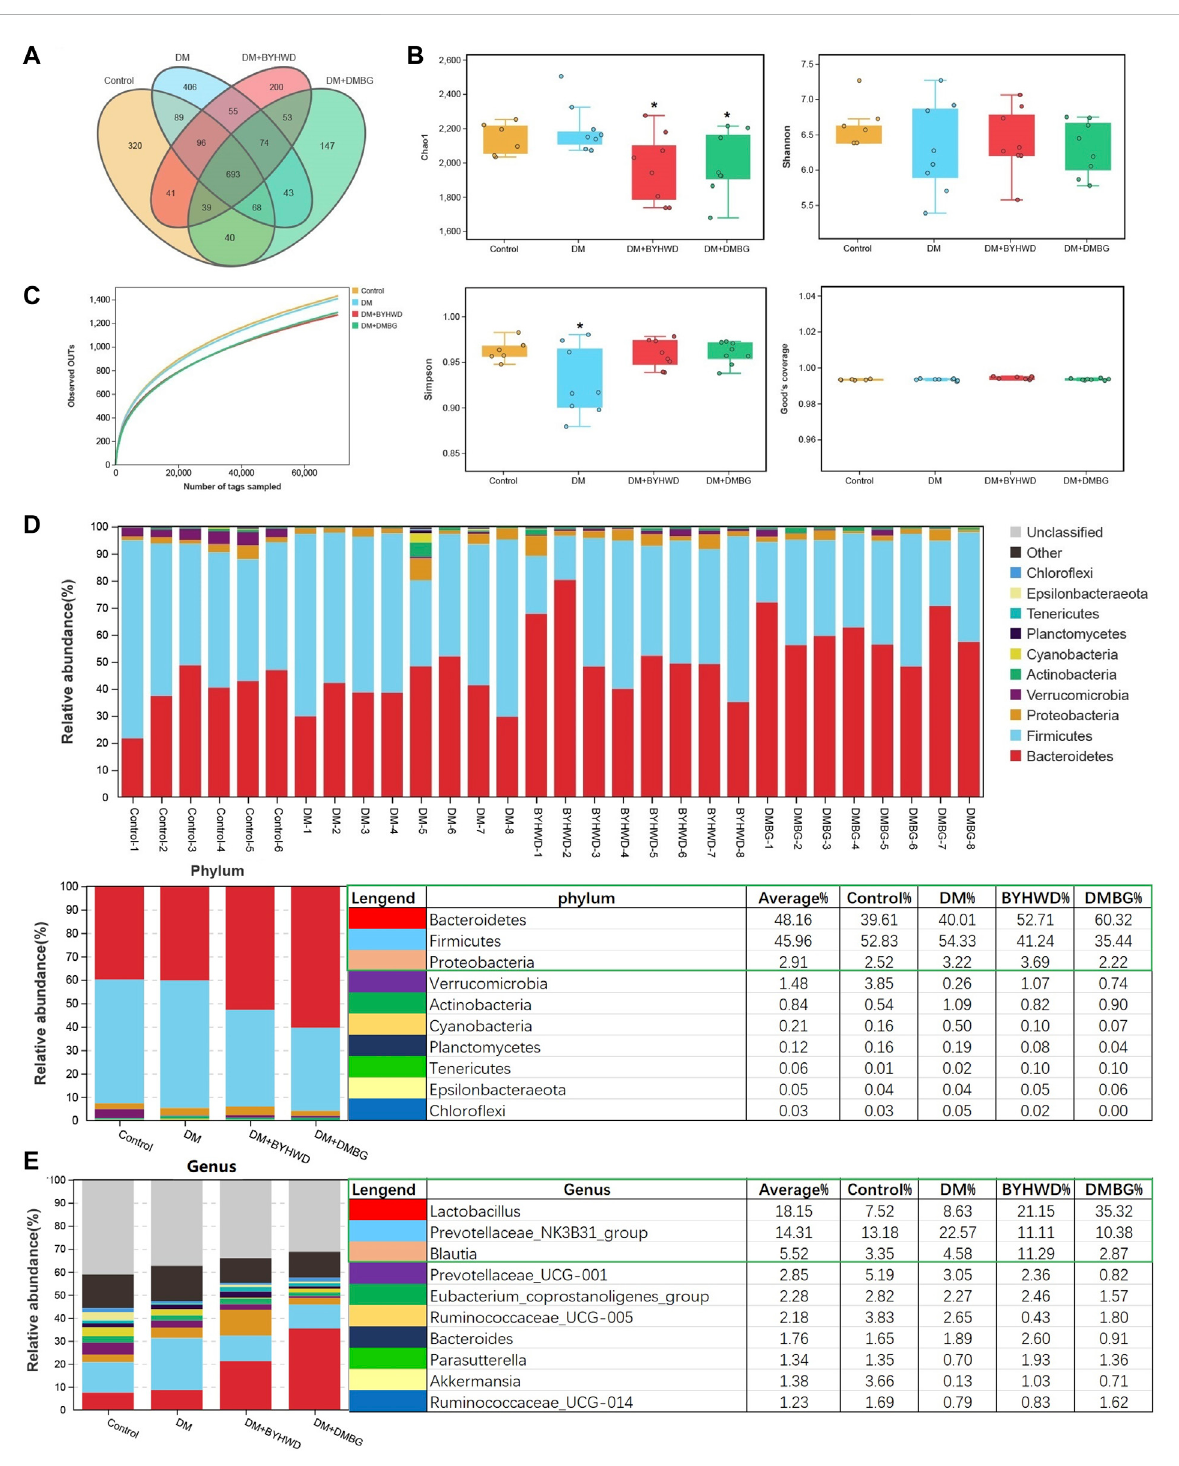
FIGURE 4 In fl uences of BYHWD on gut microbiota in diabetic ZDF rats: (A) Venn analysis; (B) alpha-indexes of Chao1, Shannon, Simpson, and Good ’ s coverage comparison among the four groups; (C) observed OTUs; (D) the histogram of the top 10 phyla of the relative abundance of the intestinal fl ora; (E) the histogram of the top 10 genera of the relative abundance of the intestinal fl ora. Data are shown as means ± S.D ( n = 6 – 8). Statistical analysis was performed using one-way ANOVA, followed by Tukey ’ s multiple comparisons test for the false discovery rate. * p < 0.05 and ** p < 0.01 were set to compare the mean of each group with the mean of the DM